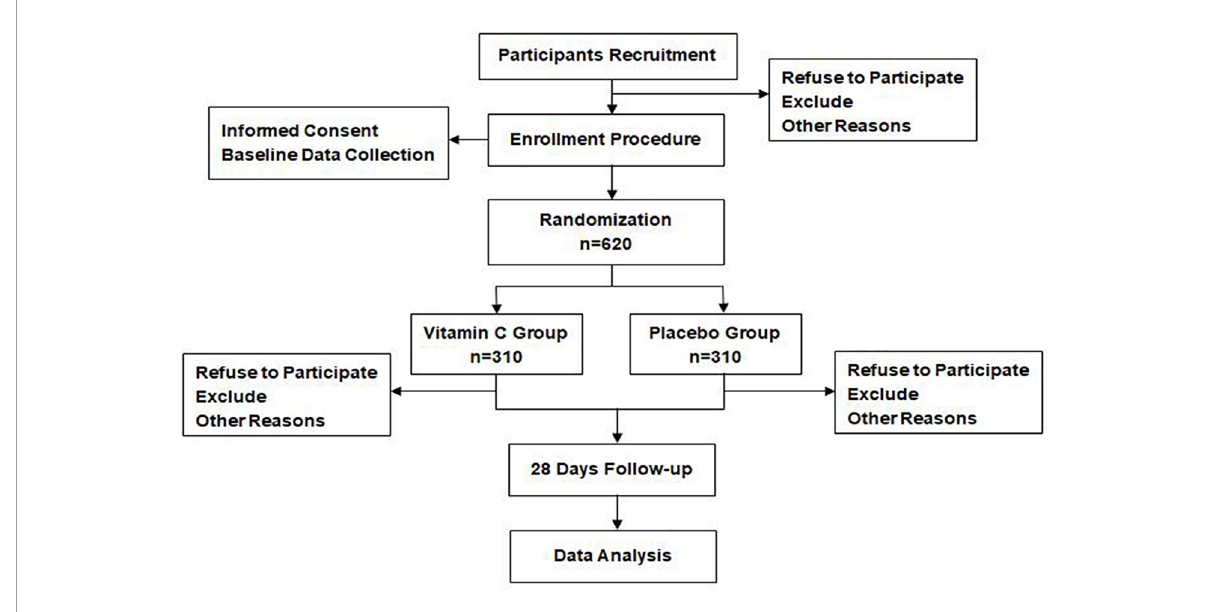
FIGURE1 Participants flow